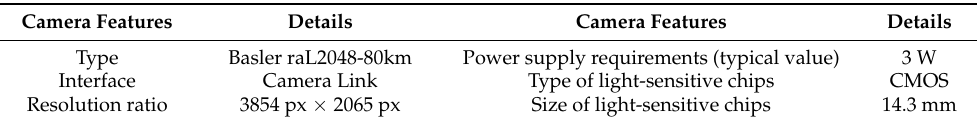
Figure 1. Mobile mapping system used to collect pavement images. Table 1. Technical parameters of the high-definition